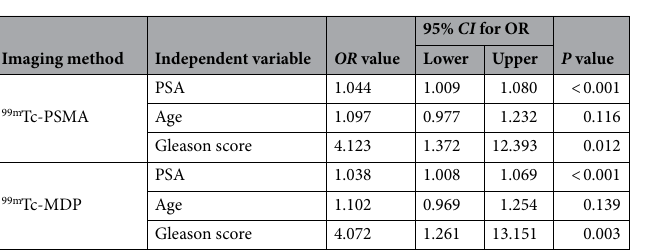
Table 5. Logistic regression analysis of related factors for the presence of clinical bone metastases on 99m Tc- PSMA and 99m Tc-MDP. CI confidence interval, OR odds ratio.